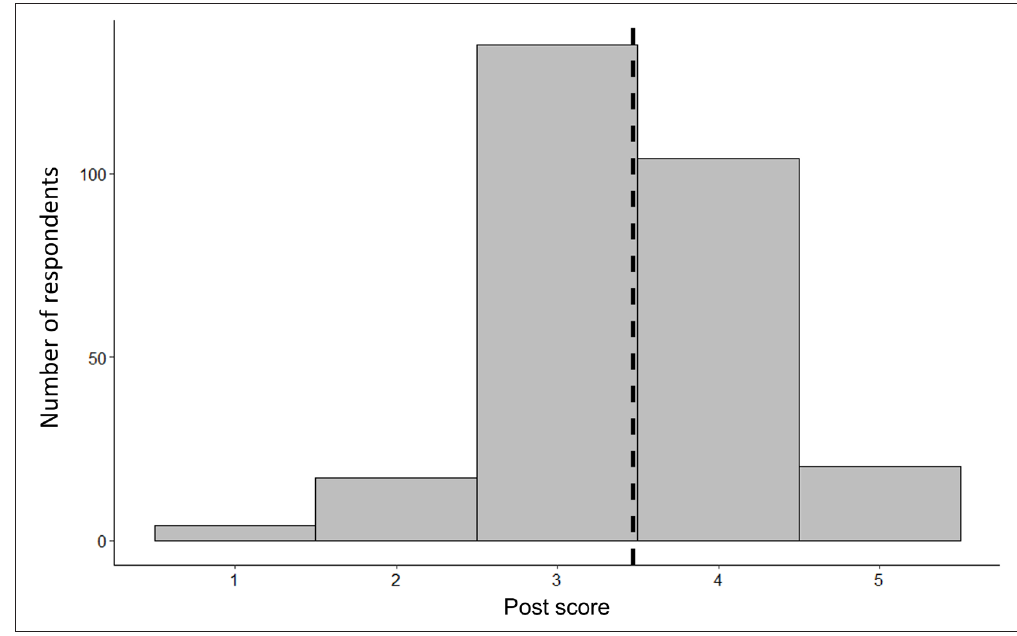
Figure 5 For the self-reported improvement in science inquiry skills score, the distribution of scores with the mean shown as a dashed line.